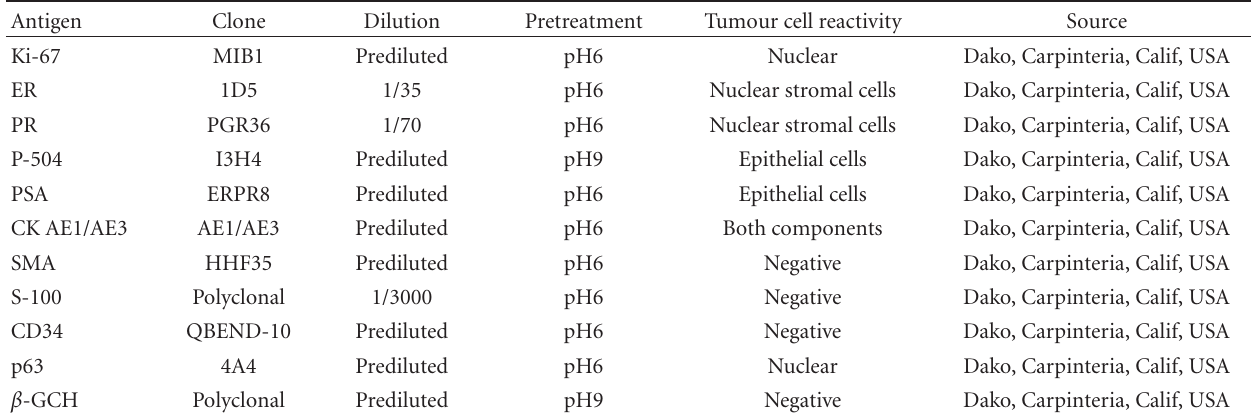
Table 1: Antibodies used for immunohistochemical